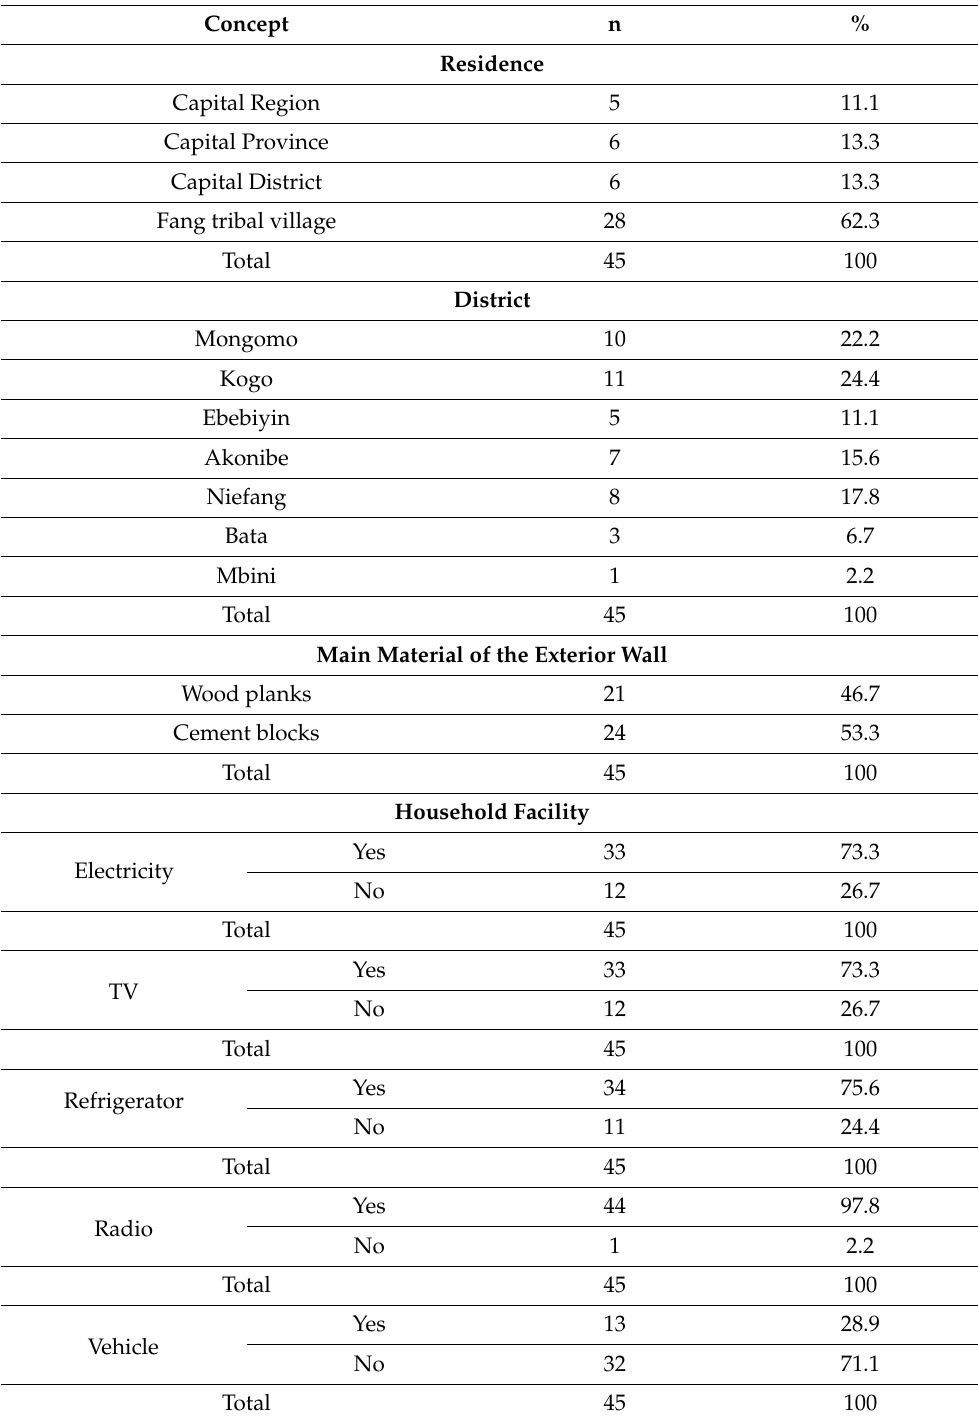
3. Socio-demographic profile. Household data of participants (n =